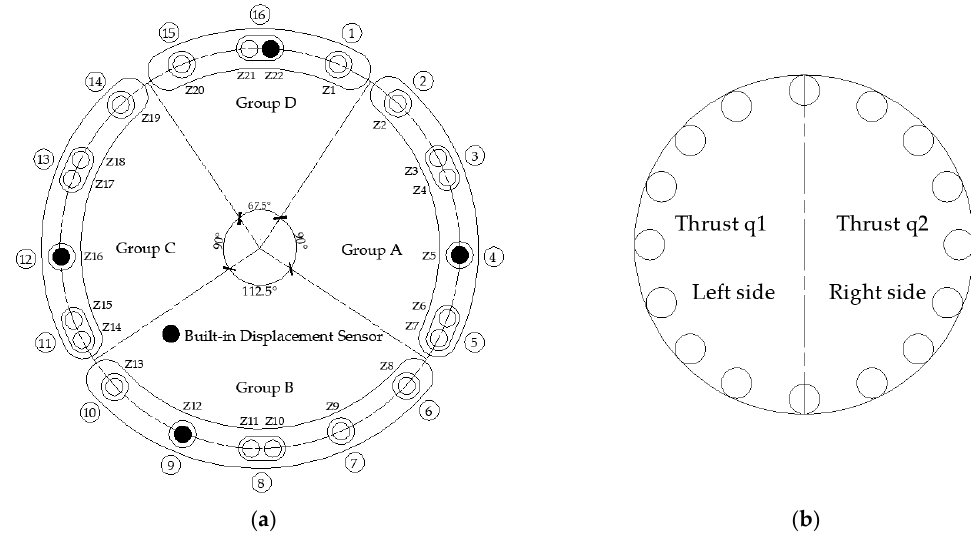
Figure 4. Arrangement and grouping of thrust: ( a ) tail jacks; ( b ) in the simulation. In order to maintain the stability of the tunnel face, it is necessary to exert sufficient pressure according to geological conditions. In this simulation, a uniform pressure of 0.15 MPa according to earth pressure at rest was applied on the tunnel face. During shield excavation, synchronous tail grouting was a significant method to control surface defor- mation. Excessive grouting pressure might lead to leakage and a decrease in filling ratio, or displacement and damage of segments and surrounding soil, whereas insufficient grouting pressure could not effectively fill tail void, which would cause excessive surface settlement. Grouting pressure was determined by monitoring data of surface settlement and similar engineering experiences and adjusted with excavation. Shield tail void, filling range of tail grouting and disturbance range of tunnel excavation were generalized as a homogeneous, isopachous and elastic equivalent circular layer [39]. In simulation, seg- ments and shell of shield were generally considered as a homogeneous ring around the tunnel [40]. With the advance of shield excavation, solidification of the grouting layer was simulated by variation of elastic modulus. After solidification, elastic modulus of grouting layer was 10 times that before [41]. Physical and mechanical parameters of materials are listed in Table 3. Table 3. Physical and mechanical parameters of materials in the simulation.